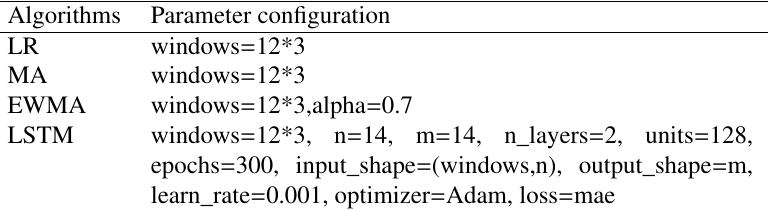
Table 2. Prediction algorithm parameter